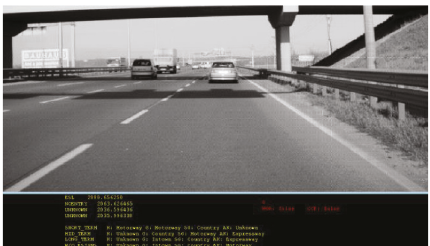
Figure 4: Screenshot showing a road location on a motorway near Budapest, Hungary. The multiscale category values displayed at the bottom are repeated in Table 8 for readability.